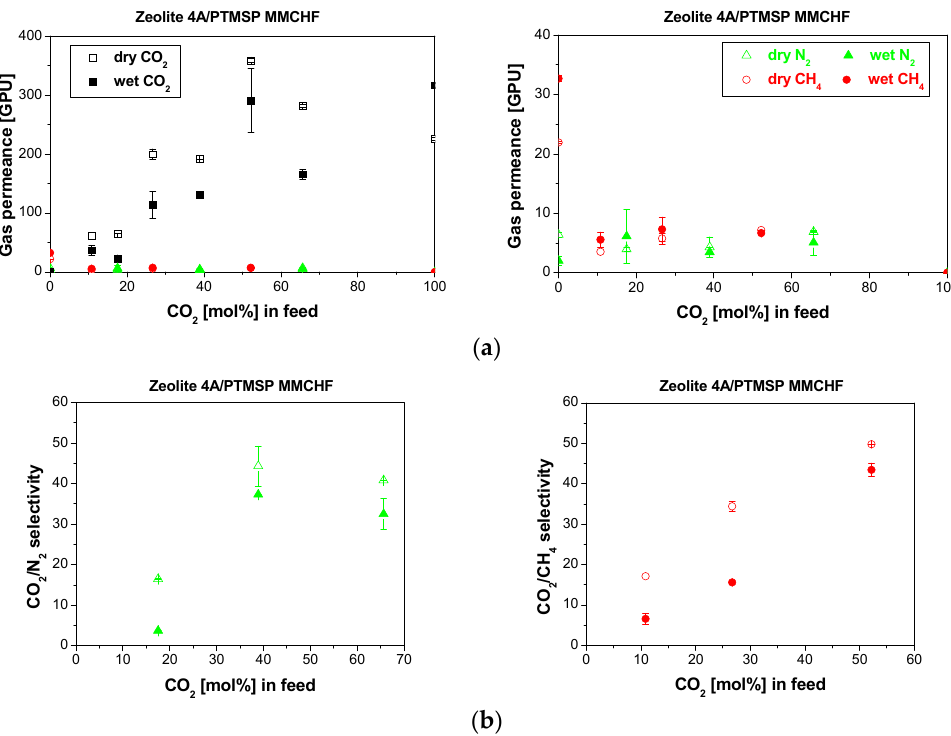
Figure 7. Gas permeance ( a ) and selectivity ( b ) obtained for the separation of CO 2 /N 2 (left) and CO 2 /CH 4 (right) mixtures through the Zeolite A/PTMSP/P84 MMCHF membrane in dry (void symbols) and wet (full symbols). The right side of figure ( a ) shows the trend in the slow gas (N 2 , CH 4 ) permeance. In the feed. The combination of hydrophilic Zeolite A and PTMSP in the selective layer of the composite membrane provided a stable performance at 25 wt.% CO 2 concentration in the